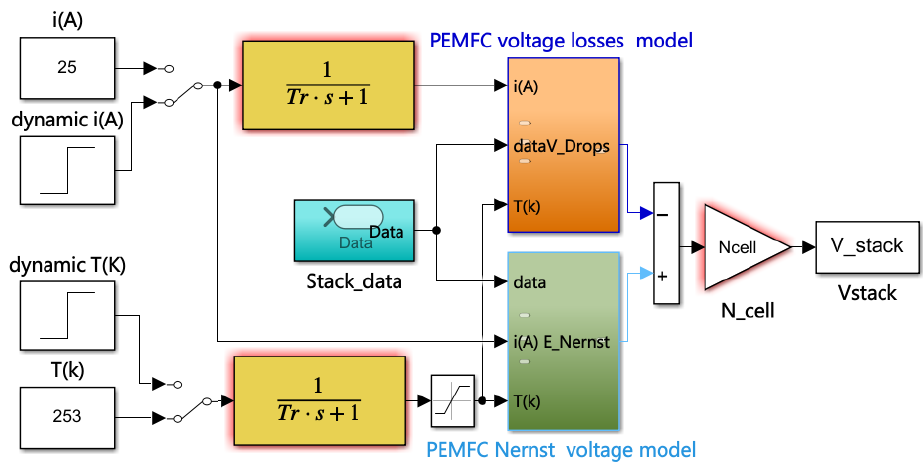
Figure 8. PEMFC simplified dynamic